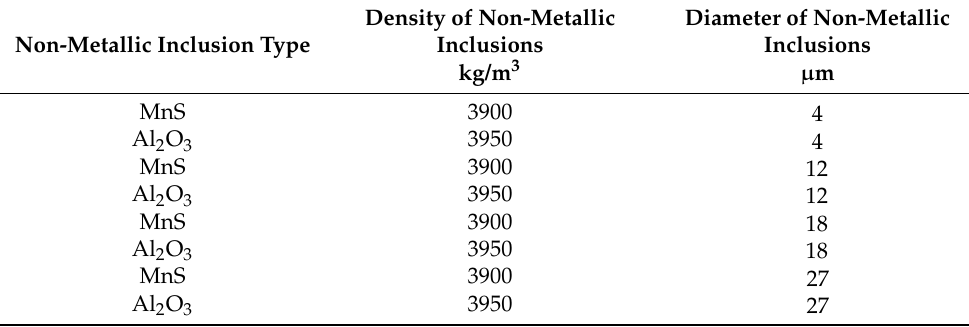
Table 7. The considered sizes of inclusions and their density in numerical simulations.